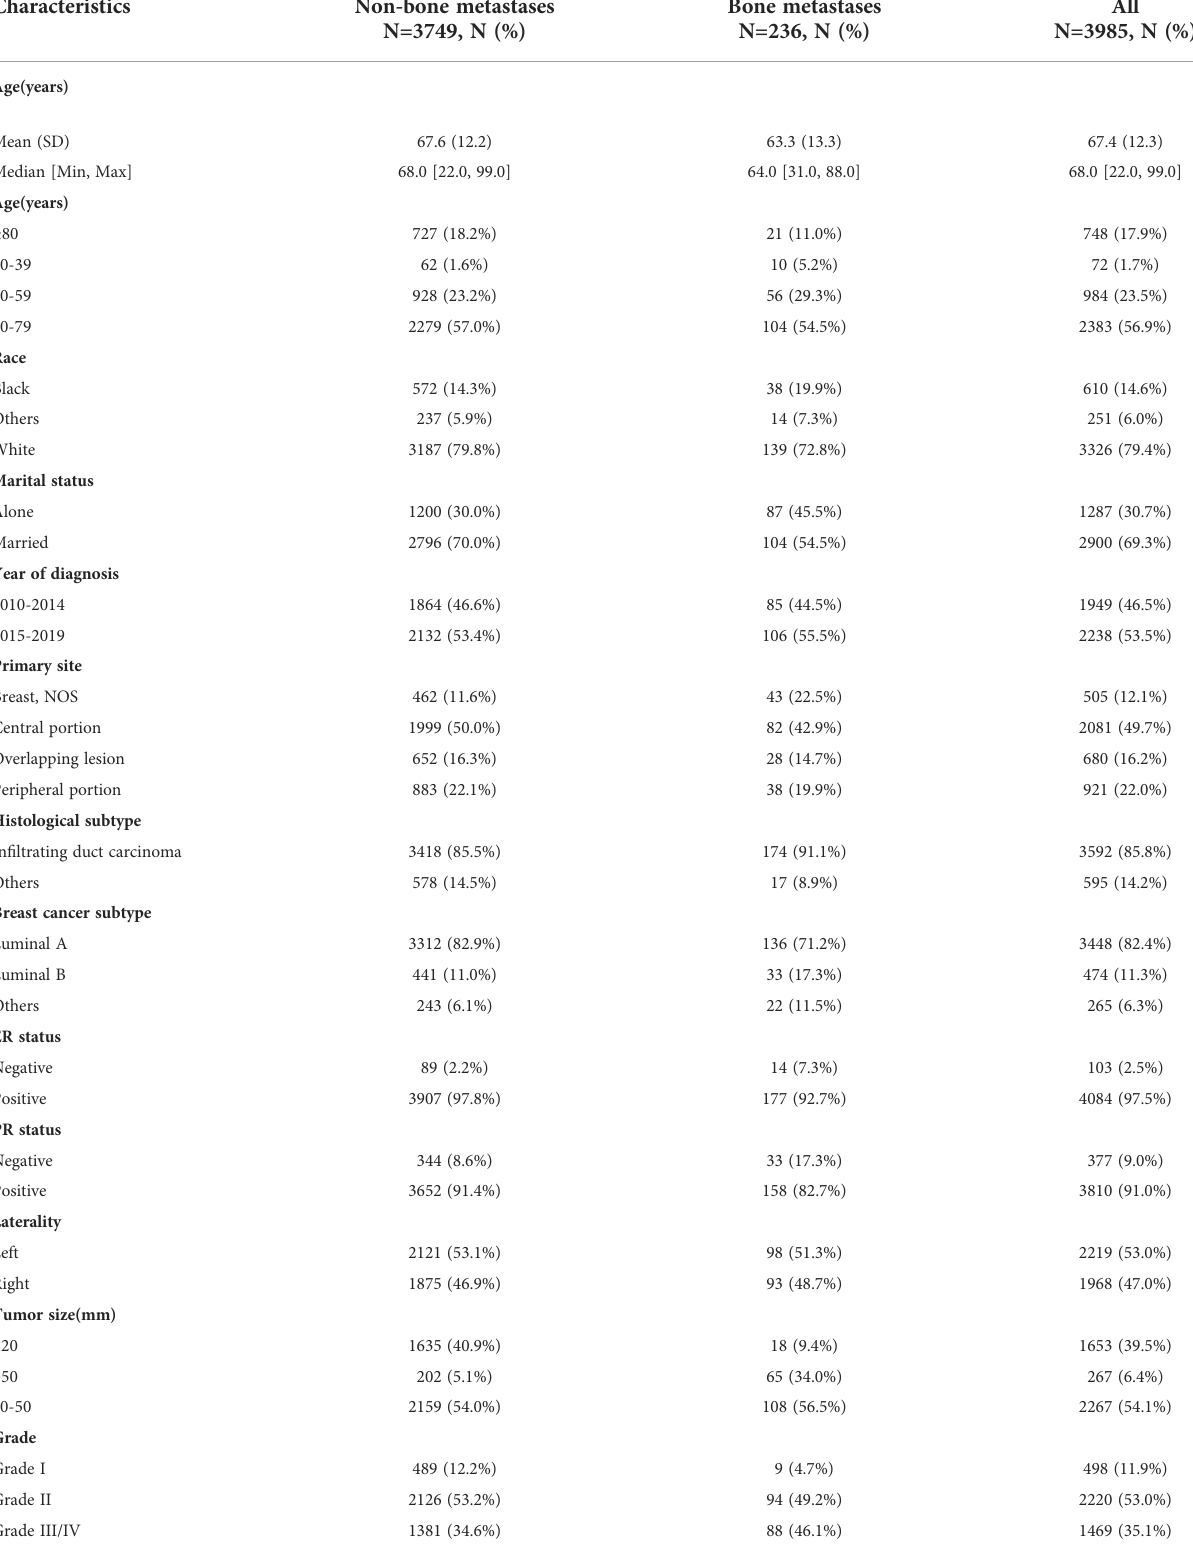
TABLE 1 Baseline demographic and clinicopathological characteristics of all MBC